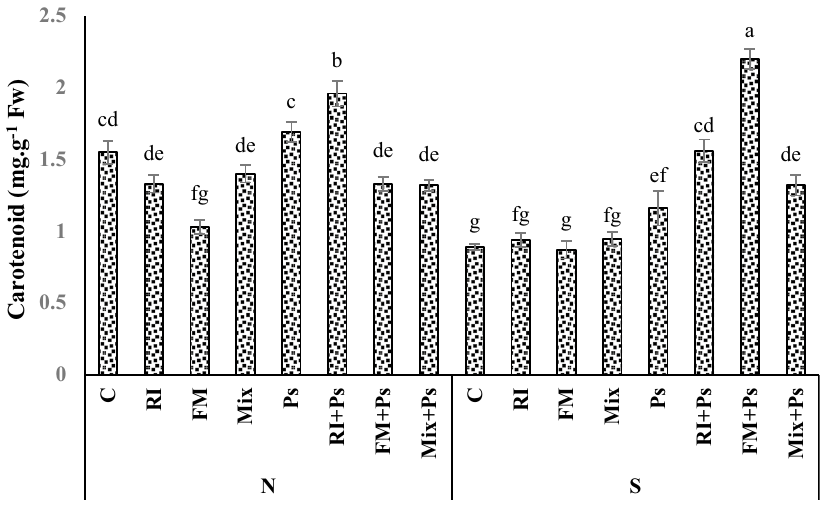
Figure 2. Interactions of irrigation regime × mycorrhizae × rhizobacterium on carotenoid contents of Arizona cypress seedlings. N well watered (100% field capacity); S: water stress (50% field capacity); RI Rhizophagus irregularis , FM Funneliformis mosseae ; Mix R. irregularis – F. mosseae mixture, C non-inoculated plants, Ps Pseudomonas fluorescens